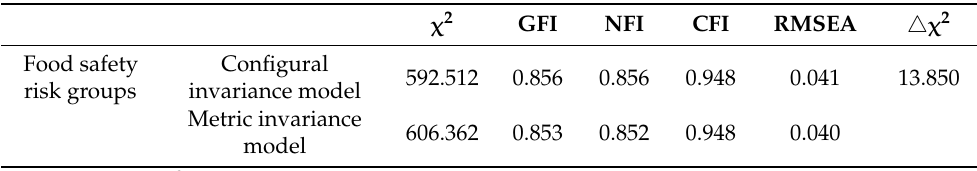
Table 5. Model fit indices of food safety risk groups.